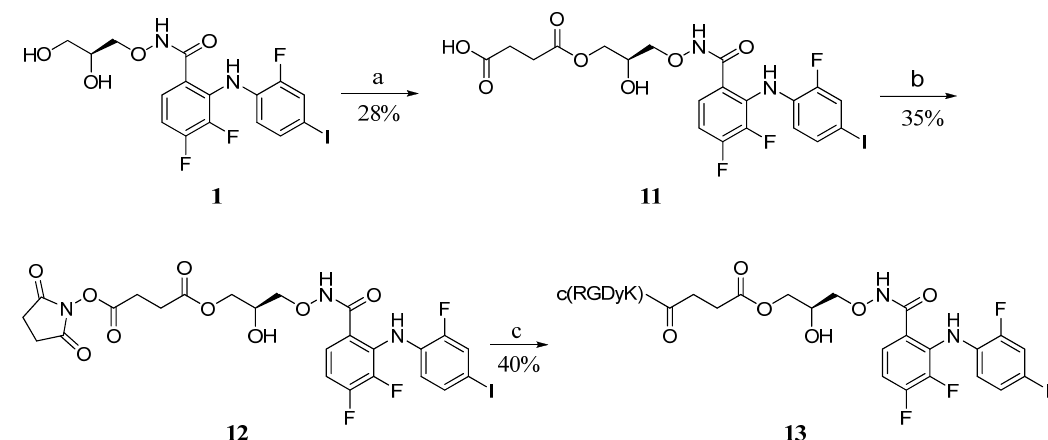
Scheme 4. Synthesis of the RGD-PD0325901 direct conjugate 13 .